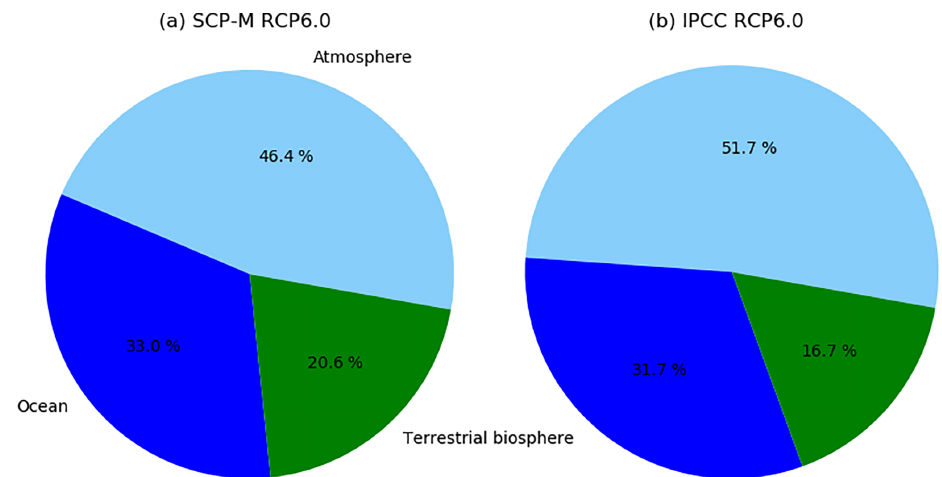
Figure 8. Relative uptake of CO 2 across the major carbon reservoirs by 2100 in RCP6.0 as modelled by SCP-M (left panel). By 2100, SCP-M projects that 46% of industrial-era emissions will remain in the atmosphere, 33% reside in the ocean and 21% in the terrestrial biosphere. Shown in panel (b) are results from Earth system models reproduced from the IPCC Working Group 1 5th Assessment Report, Chapter 6 (IPCC,